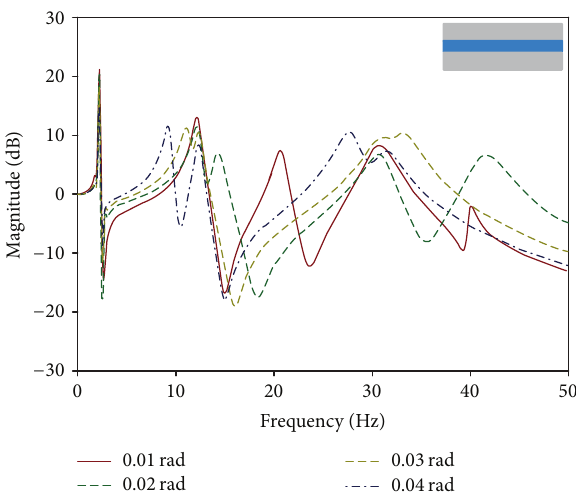
Figure9:Frequencyresponseofcylindricalaluminumpanelincase of SSDL with variety of damping factors 𝜂 of viscoelastic material ( 𝑎 = 0.2 m, 𝜙 = 0.01 rad, 𝑅 = 20 m, 𝑡 1 = 5 mm, 𝑡 2 = 2 mm, and 𝑡